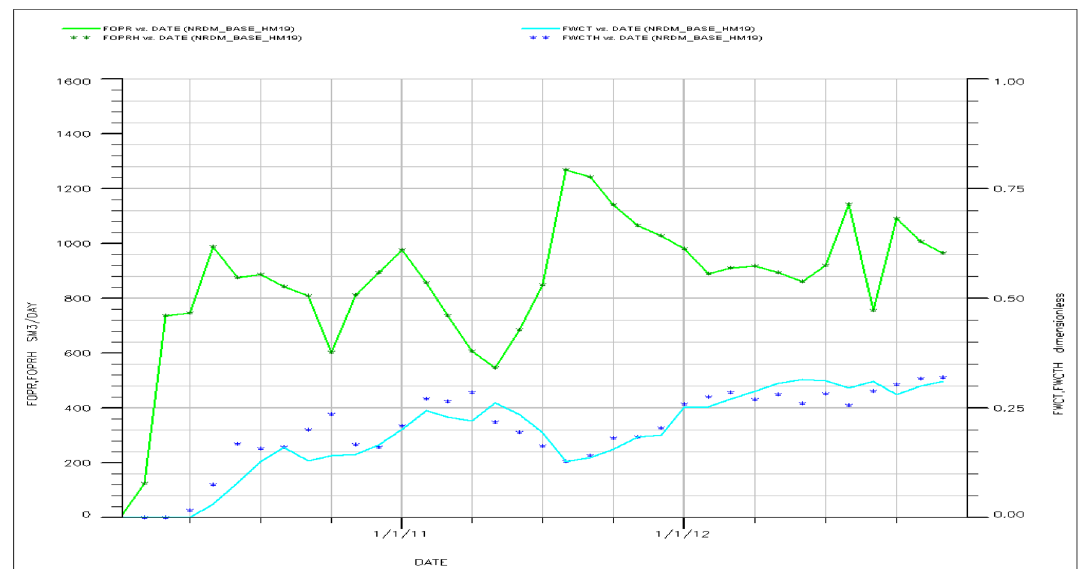
Fig. 6 Field matching results